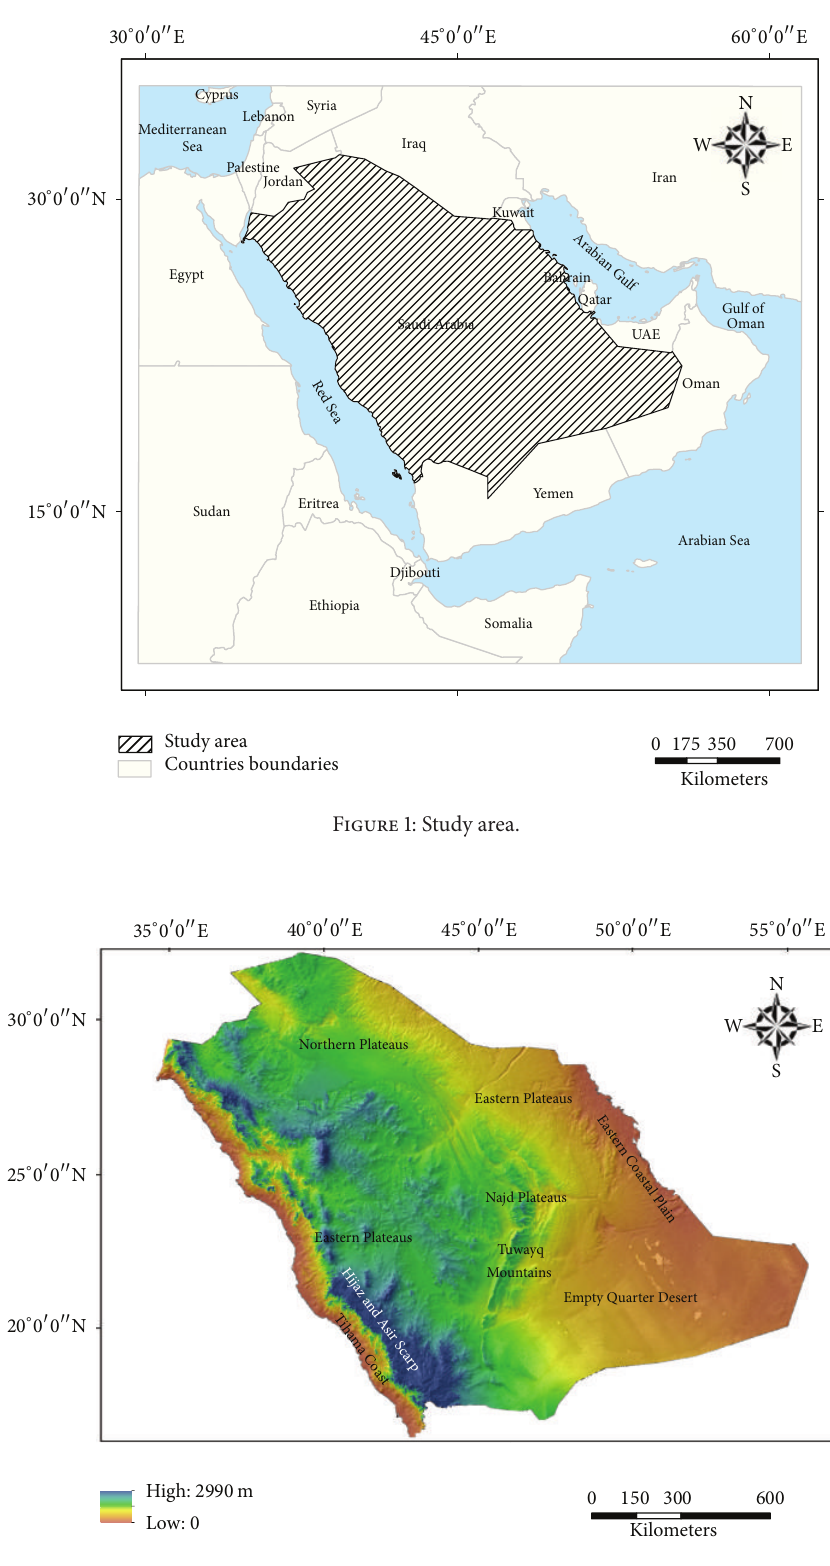
Figure 2: Digital elevation model of Saudi